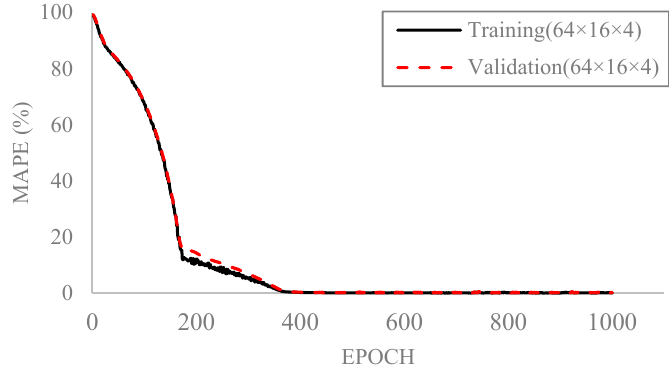
Figure 11. Accuracy of DNN model with training and validation in terms of MAPE.